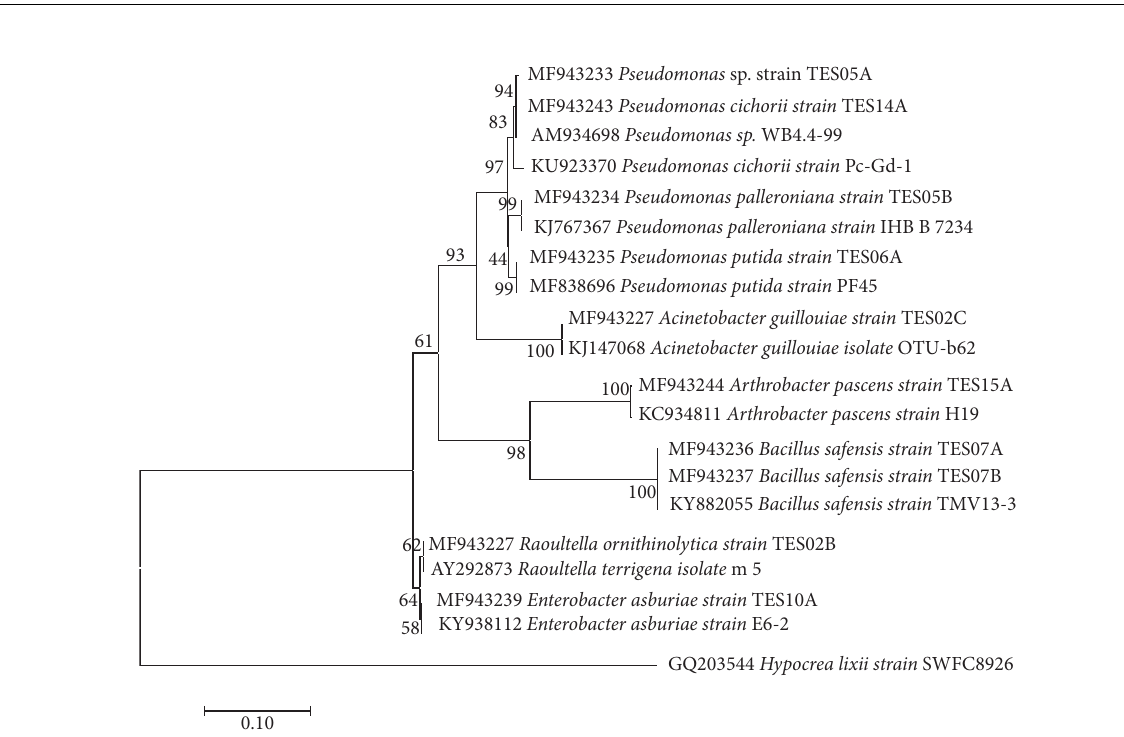
Figure 1: Neighbor-joining phylogenetic tree of 16S rRNA gene sequences of endophytes isolated from C. macowanii leaves showing the relationship with other similar species selected from GenBank.